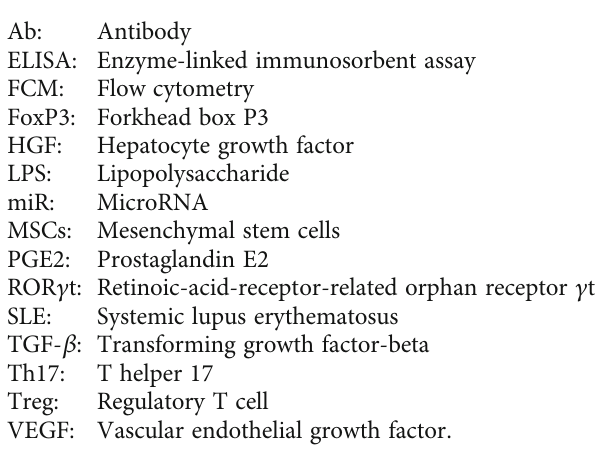
Figure S1: the purity of isolated CD4 + T cells from mouse spleen using CD4 (L3T4) microbeads was identi fi ed by fl ow cytometric analysis of CD4 staining. Figure S2: the transfec- tion e ffi ciency of miR-155 mimic and control was detected at 4 (A) and 48 (B) hours by qRT-PCR. ∗ P < 0 : 05 and ∗∗ P < 0 : 01 . Figure S3: Ptpn2 mRNA might be one of the potential targets with 3 ′ -UTR area binding miR-155. Agarwal et al. ure S4: graphical abstract. miR-155 suppression of CD4 + T cells mediated MSC-secreted TGF- β 1 modulating skewed Treg/Th17 induced by LPS-hypoxia challenge. Table S1: primer sequence for gene detection.